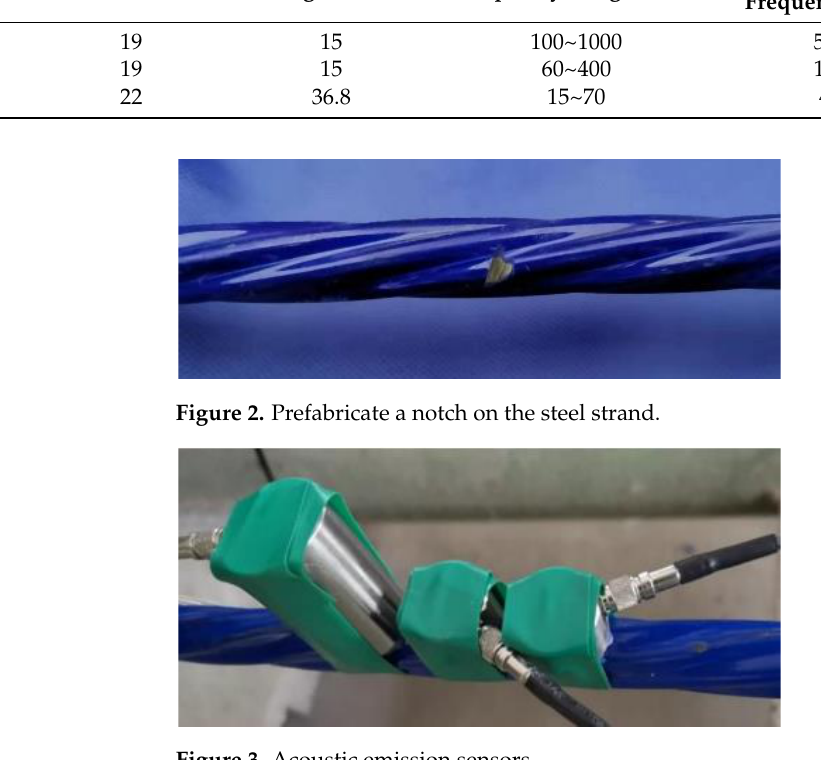
Figure 4. Schematic picture of the tensile load application process. Figure 5. Steel strand acoustic emission monitoring system. Figure 6. Working interface of upper computer acquisition software.